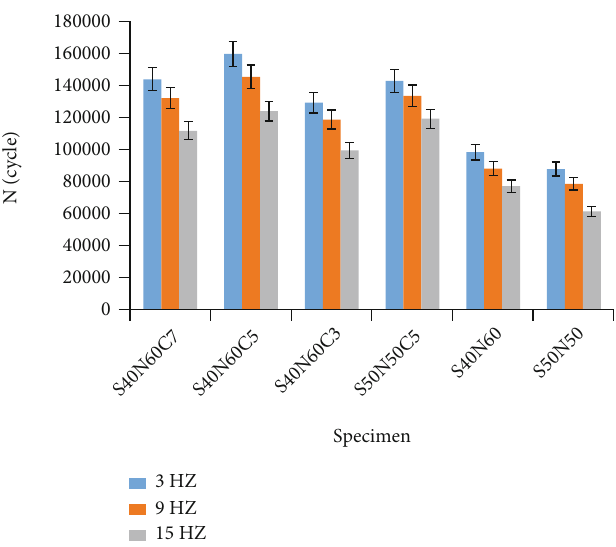
Figure 9: Fatigue life changes of di ff erent samples at 60% strain and at frequencies of 3 Hz, 9Hz, and 15Hz.